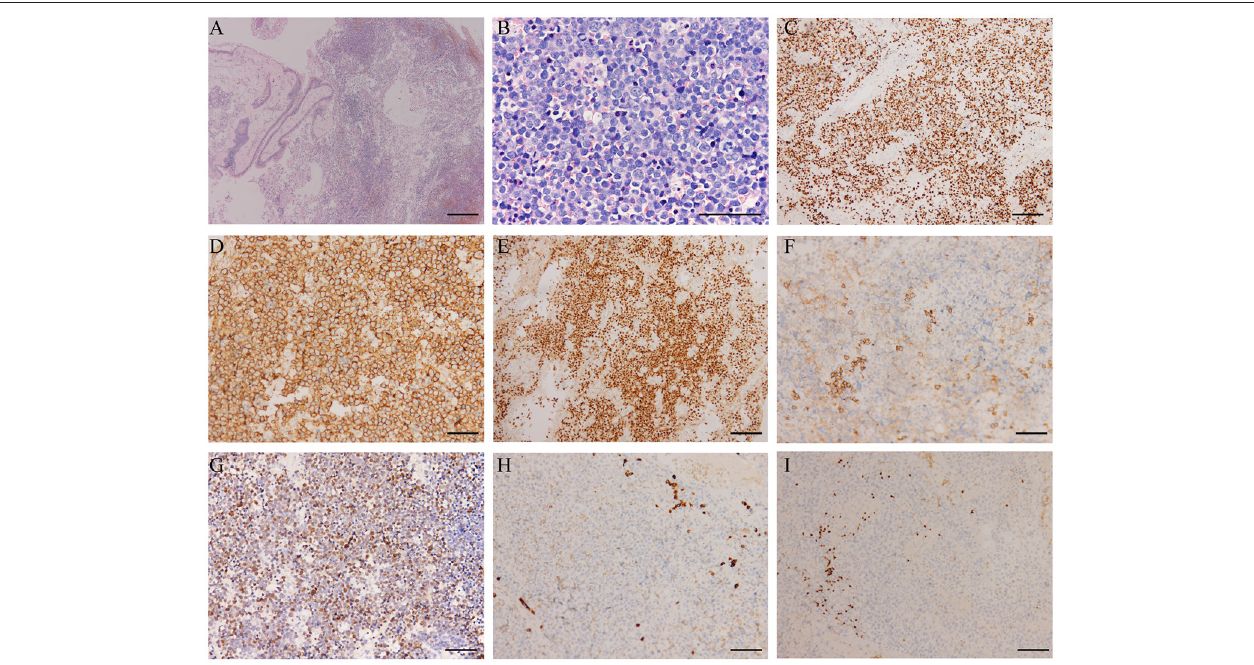
FIGURE 2 | Histopathological features of the plasmablastic lymphoma (PBL) patient. (A) PBL consists of large atypical cells, which cause destroyed architecture (H&E; scale bar, 500 µ m). (B) The higher power view shows large-sized atypical cells with lymphocytic or plasmacytoid morphology, accompanied by obvious nucleoli and pathological mitotic features (H&E; scale bar, 100 µ m). (C) The proliferation index was high with a Ki-67 expression of almost 95% (scale bar, 200 µ m). (D) The immunohistochemical profile showed the neoplastic cells were strongly positive for the plasma cells markers CD38 (scale bar, 100 µ m) and (E) MUM-1 (scale bar, 200 µ m), positive for CD138 (scale bar, 100 µ m) (F) . (G) EBER in situ hybridization showed positive staining of plasmablasts (scale bar, 100 µ m). The malignant cells did not express CD20 (scale bar, 100 µ m) (H) and PAX-5 (scale bar, 100 µ m) (I)